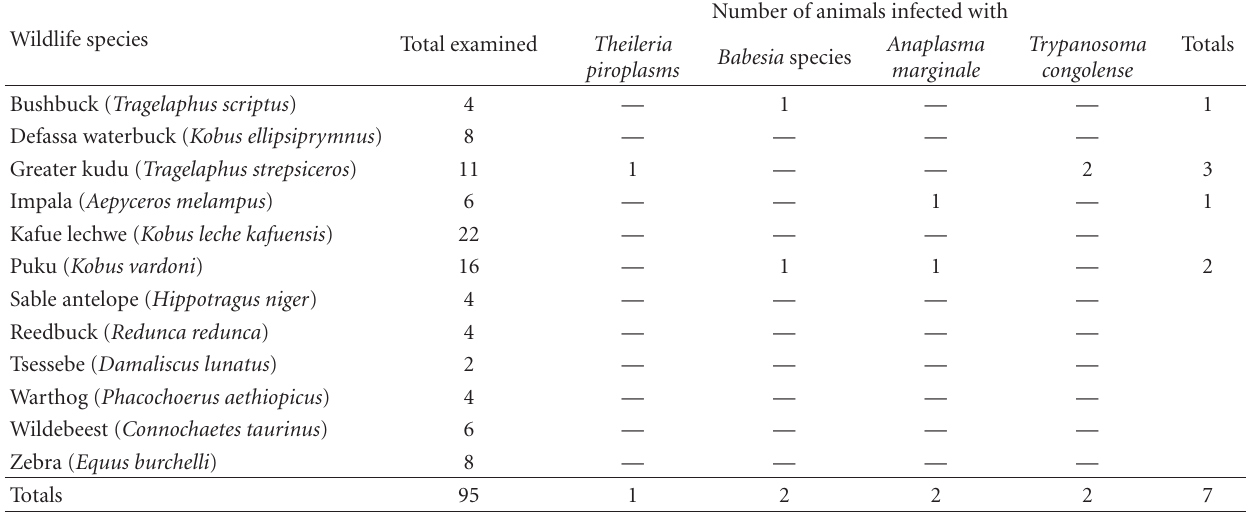
Table 2: Haemoparasites detected from blood